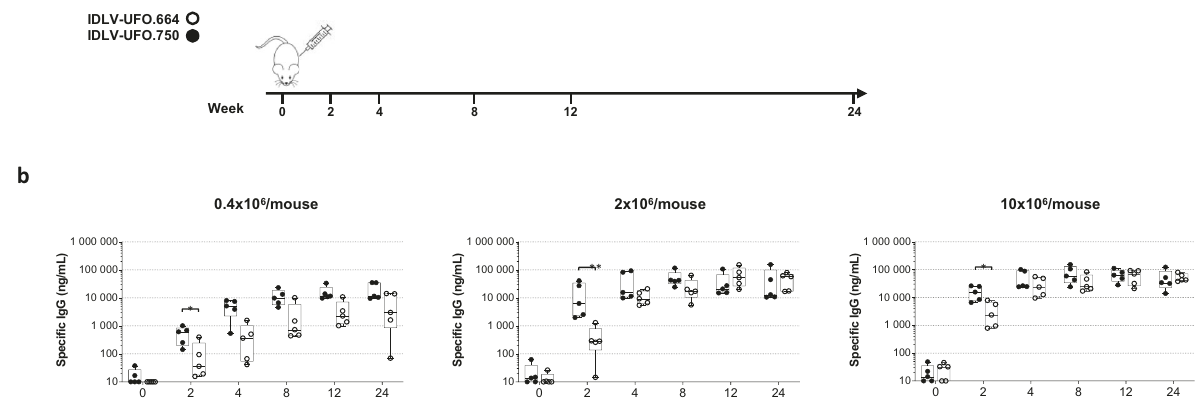
Fig. 6 Immune response in mice immunized with IDLV delivering soluble or membrane-tethered ConSOSL.UFO. a Immunization schedule of BALB/c mice. Five mice/group were vaccinated once with escalating doses (0.4 × 10 6 , 2 × 10 6 , 10 × 10 6 RT units/mouse) of SIV-based IDLVs expressing either soluble ConSOSL.UFO.664 or membrane-tethered ConSOSL.UFO.750. Sera were collected at the indicated time point. b Time course of anti-ConSOSL.UFO Env IgG measured by ELISA in sera of BALB/c mice (5 mice/group) immunized with either IDLV-UFO.750 (black dots) or IDLV-UFO.664 (empty dots). Samples from immunized mice were analyzed separately. Results are expressed as IgG ng/ml and shown as box and whisker plots. * p < 0.05, ** p < 0.01, Mann-Whitney test.